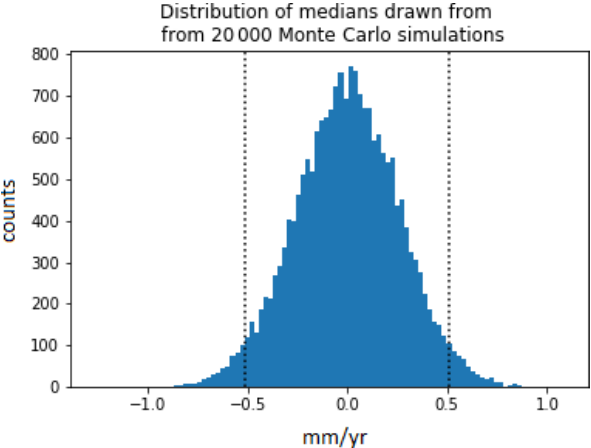
Figure B1. Histogram of median values of randomly sampled sub- sets. The subsets consist of 52 samples (according to the number of TGs in AVISO–PSMSL-250km) and are randomly drawn from normally distributed values with zero mean and a standard deviation of 1.5mmyr − 1 (according to the rms ((cid:49) VLM ) of AVISO–PSMSL- 250km). Dashed lines mark the 2.5 and 97.5 percentiles of the dis-